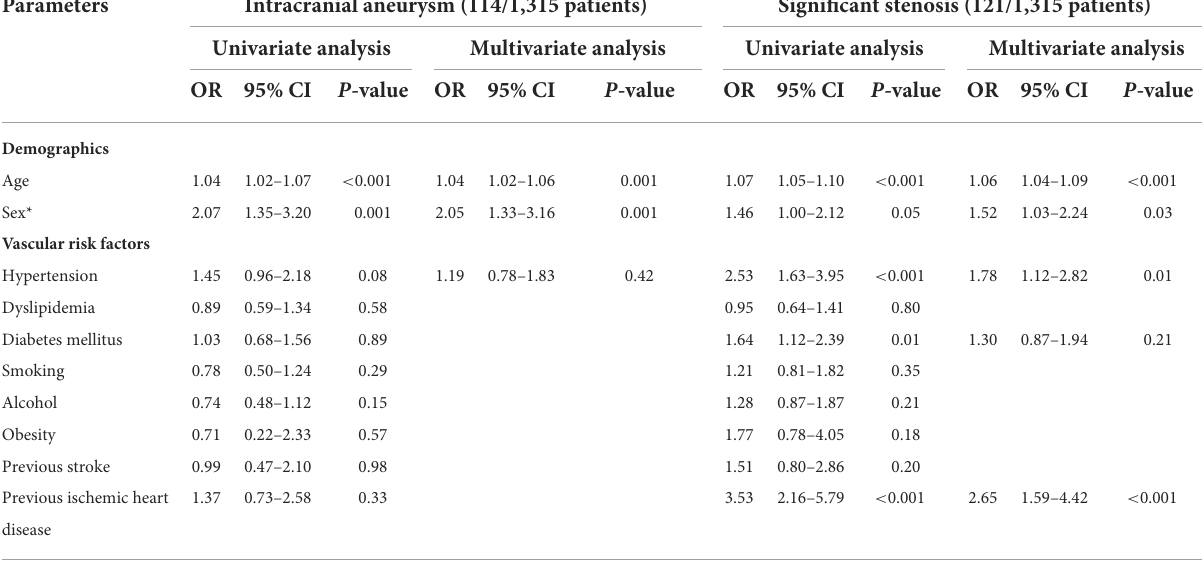
TABLE 4 Risk factors for positive findings on TOF-MRA in patients with cognitive impairment.